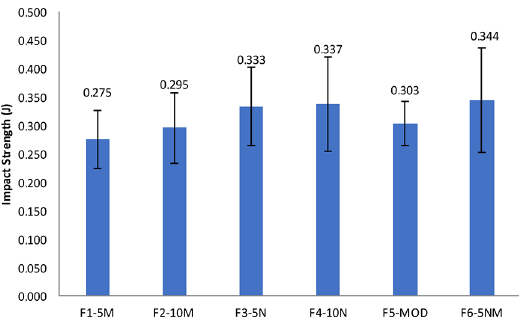
Figure 11. Impact resistance values of the PVC